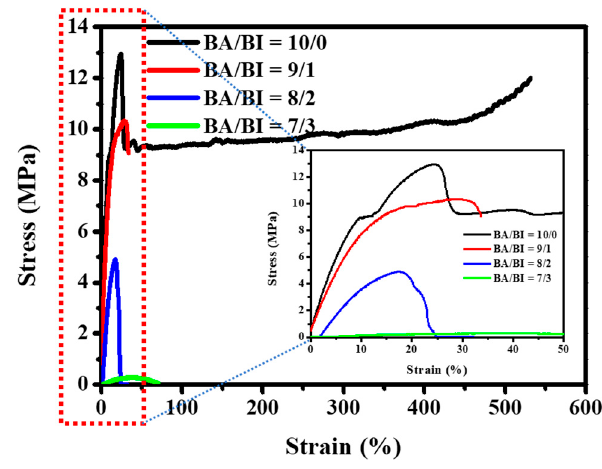
Figure 8. The stress–strain curves of the PBABI copolyesters.